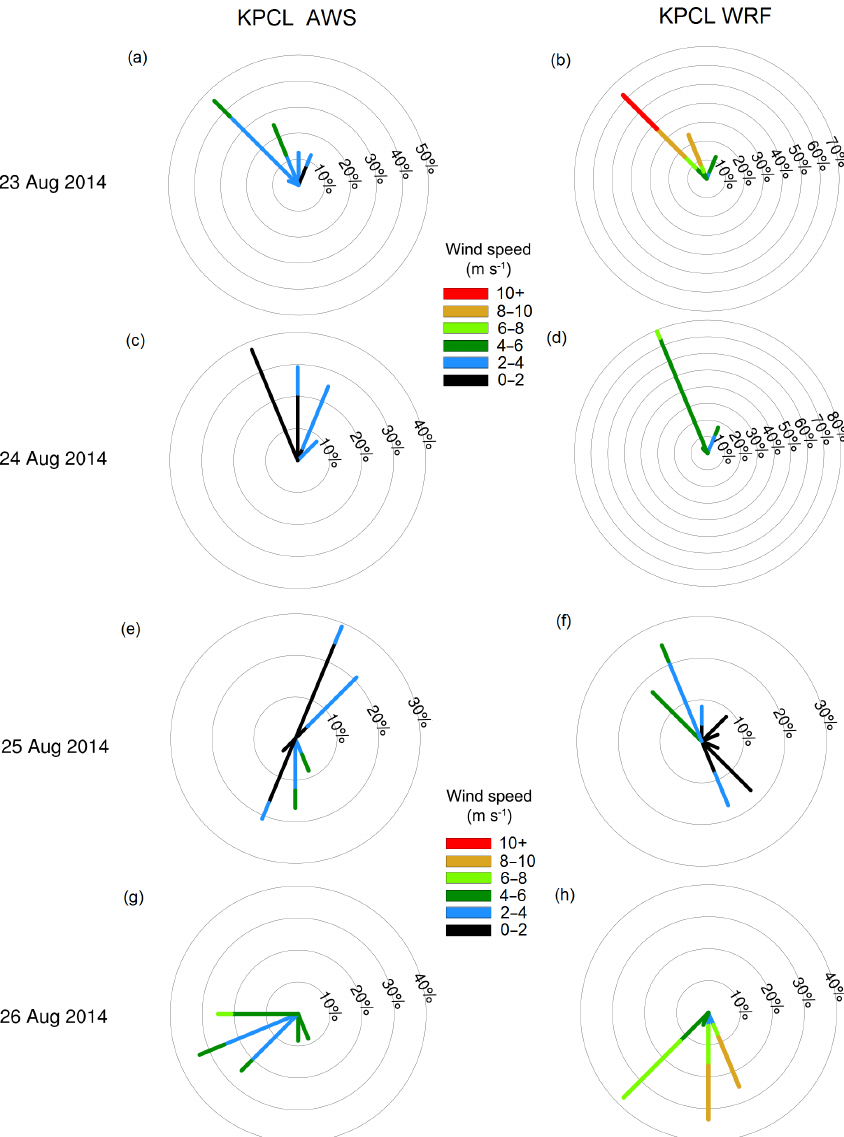
Figure 5. Wind speed (colour) and direction (lines) for 23 to 26 August 2014, from observations (a, c, e, g) and WRF (b, d, f, h) at the KPC_L location. The circles (and therefore length of the spikes) represent the frequency of the particular wind direction, with the percentage of occurrence written on the